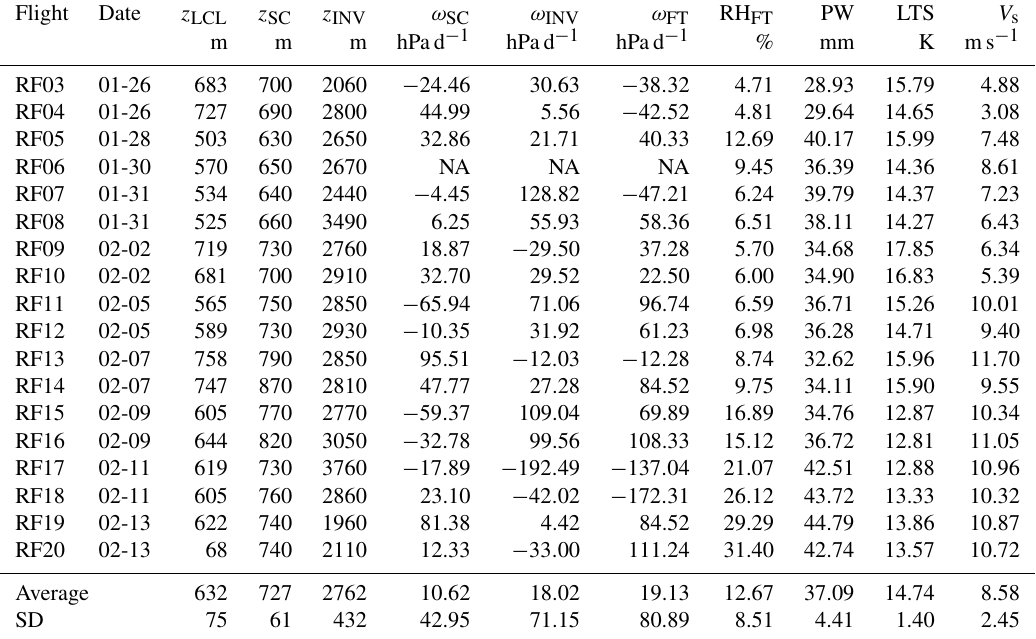
Table 3. Meteorological conditions associated with each ATR flight and their average over all flights. All quantities are computed from the JOANNE dropsonde dataset (George et al., 2021) as averages over three consecutive circles flown during each ATR flight; z INV , z SC and z LCL are the trade inversion height, the subcloud-layer top height and the lifting condensation level height, respectively; z INV is defined as the height where the moist static energy is minimum between 1300 and 4000m; z SC is defined as the lowest altitude above 200m where θ v ( z ) exceeds the mass-weighted average of θ v from 200m to z by more than 0.2K (Canut et al., 2012; Rochetin et al., 2021; Touzé-Peiffer et al., 2022); z LCL is diagnosed as z LCL = z 20m − ( C pd (( T LCL − T 20m ) /g )), with T LCL = 1 / ((1 / ( T 20m − 55)) − (log(RH 20m ) / 2840)) + 55, where T is the temperature and RH the relative humidity. ω is the vertical velocity measured at the scale of the EUREC 4 A circle by dropsondes (Bony and Stevens, 2019; George et al., 2021); ω SC and ω INV are the mass-weighted averages of ω in a 200m layer centered around z SC and z INV , respectively. ω FT and RH FT (FT referring to the lower free troposphere) are the mass-weighted averages between 4000 and 6000m of ω and RH, respectively (note that ω was not measured during RF06). PW (precipitable water) is the mass-weighted integral of water vapor specific humidity from the surface to the altitude of the dropsonde launch (about 10km). The lower-tropospheric stability (LTS) is defined as LTS = θ 700hPa − θ 1000hPa (Klein and Hartmann, 1993). V s is the near-surface wind speed computed from the zonal and meridional wind components measured by dropsondes at 20m. NA – not